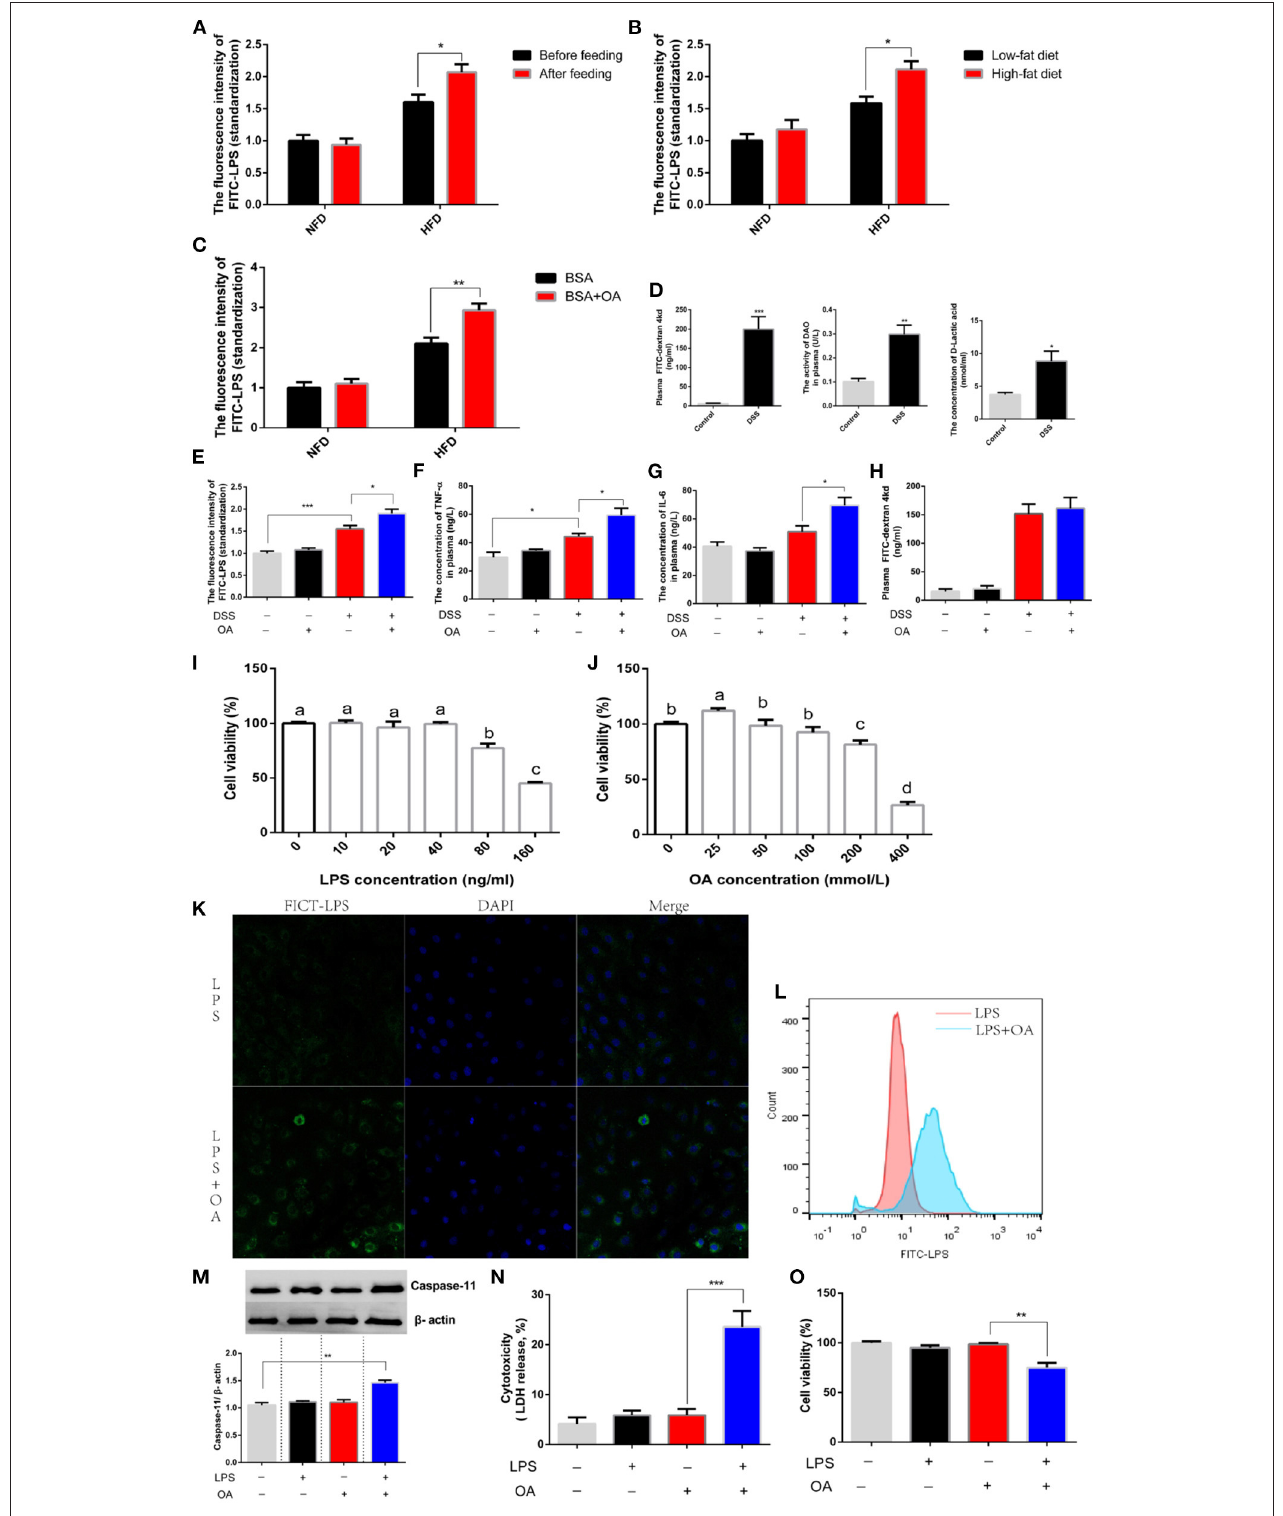
FIGURE 5 | Fatty acids assist the transfer of LPS. (A–C) The concentration of plasma FITC-LPS in fish were fed an NFD or HFD. (A) The analysis was performed in two groups (NFD and HFD) before or after feeding. (B) The analysis was performed in two groups (NFD and HFD) after feeding Low-fat diet (5% fat) or high-fat